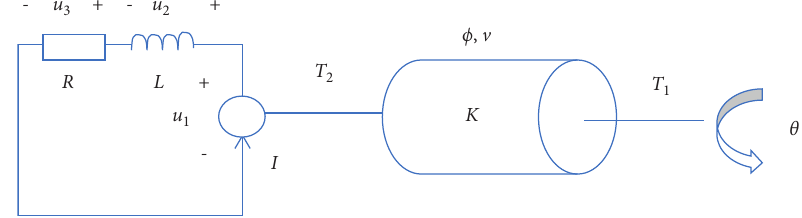
Figure 2: A model of